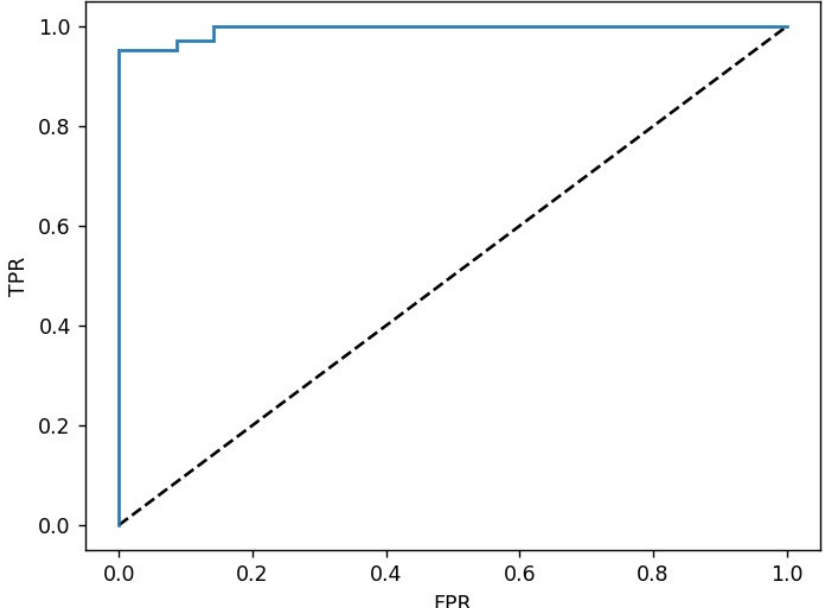
Figure 5. Plot of ROC Curve (Source: authors’ calculations based on Python programming/VS code).